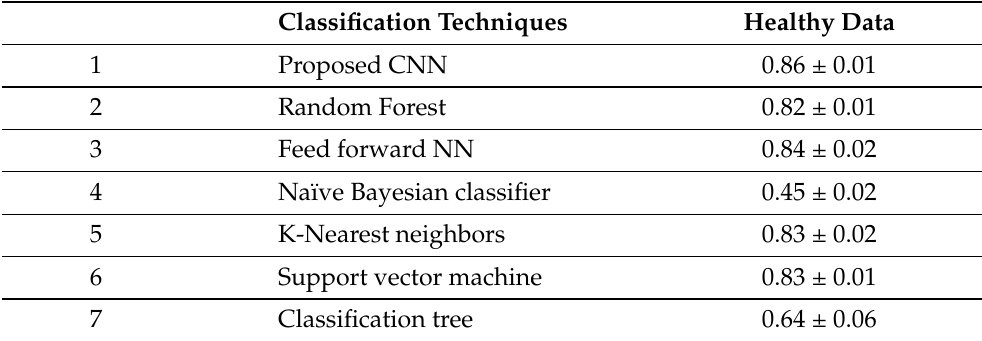
Table 2. Comparison of classification techniques with Healthy subjects’